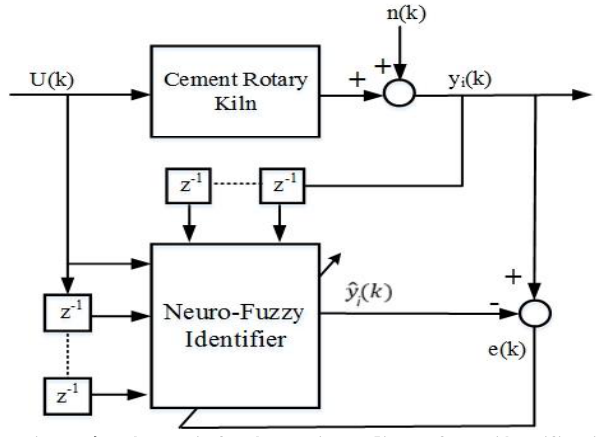
Figure 4 . Schematic for dynamic nonlinear fuzzy identification of cement rotary